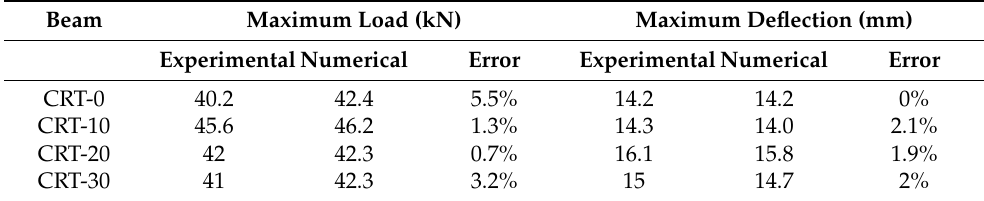
Table 4. Comparison between experimental and numerical